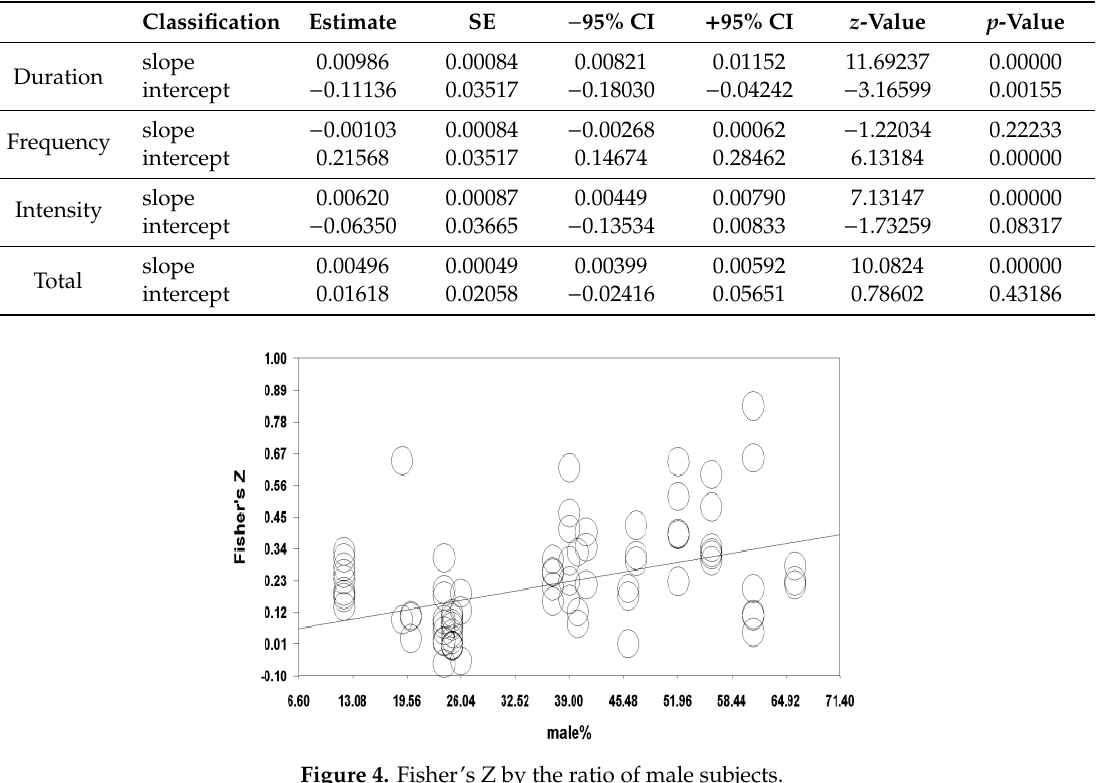
Table 4. Results of meta regression analysis with the ratio of male subjects.